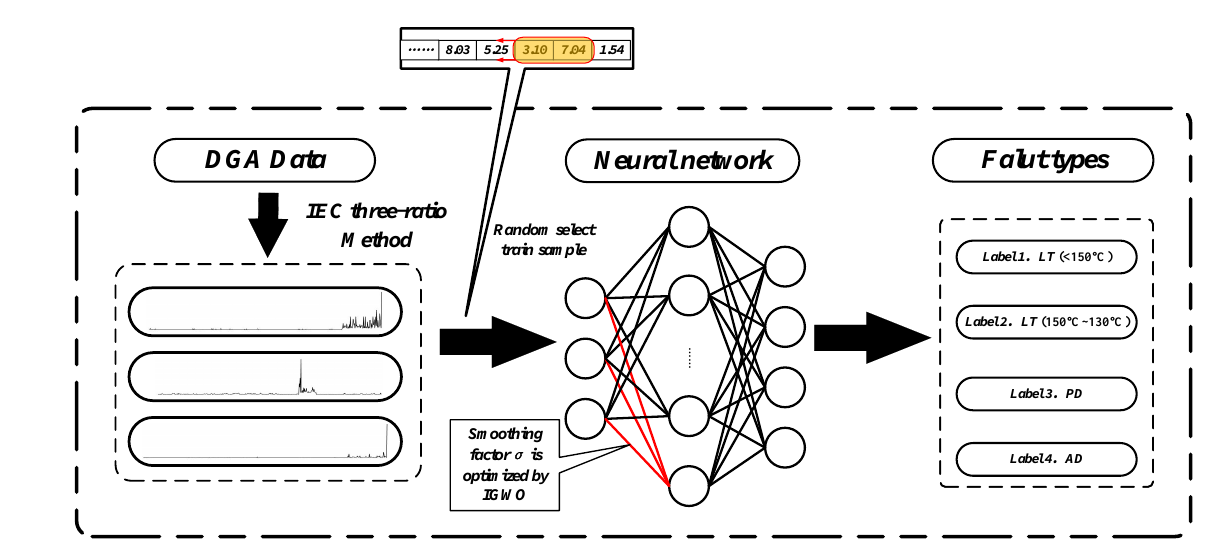
Figure 3. Power transformer fault diagnosis framework diagram.